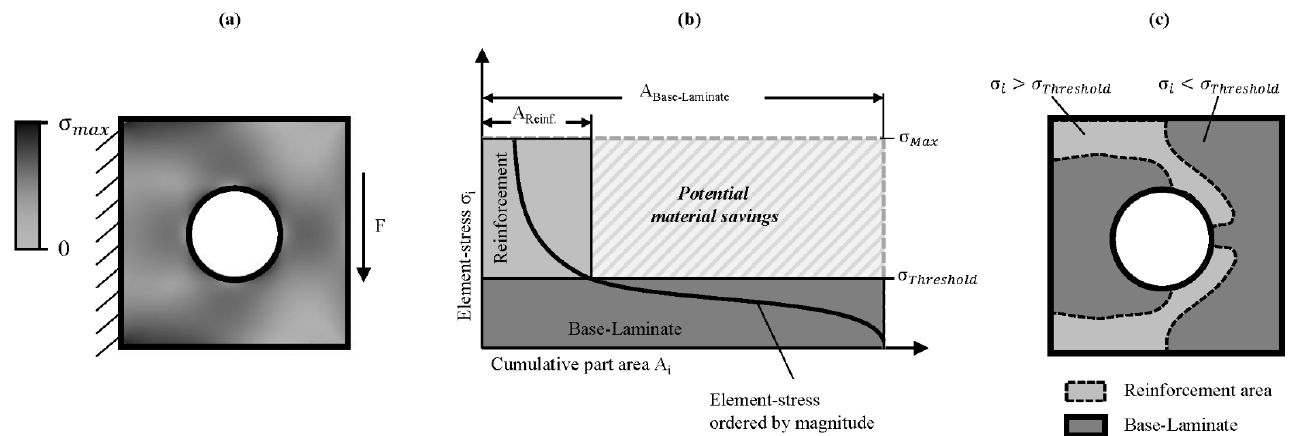
Figure 1. In ( a ), the stress distribution for a shear loaded component is given. σ Max denotes the maximum stress of the entire component. The element-stresses are ordered by their magnitude in ( b ). When splitting into base-laminate and reinforcements by the stress threshold, the total material demand is reduced. The reinforcement area is derived by all elements with element-stress σ i > σ Threshold as demonstrated in ( c ).